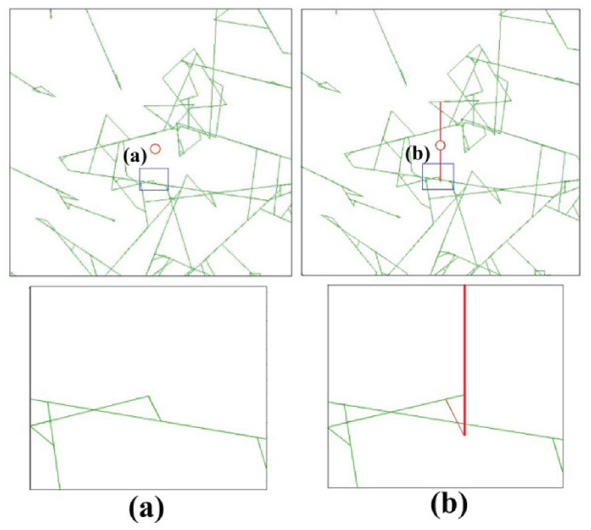
Fig. 16 The phenomenon of coalescence fractures in a 6 m long hydraulic fracture